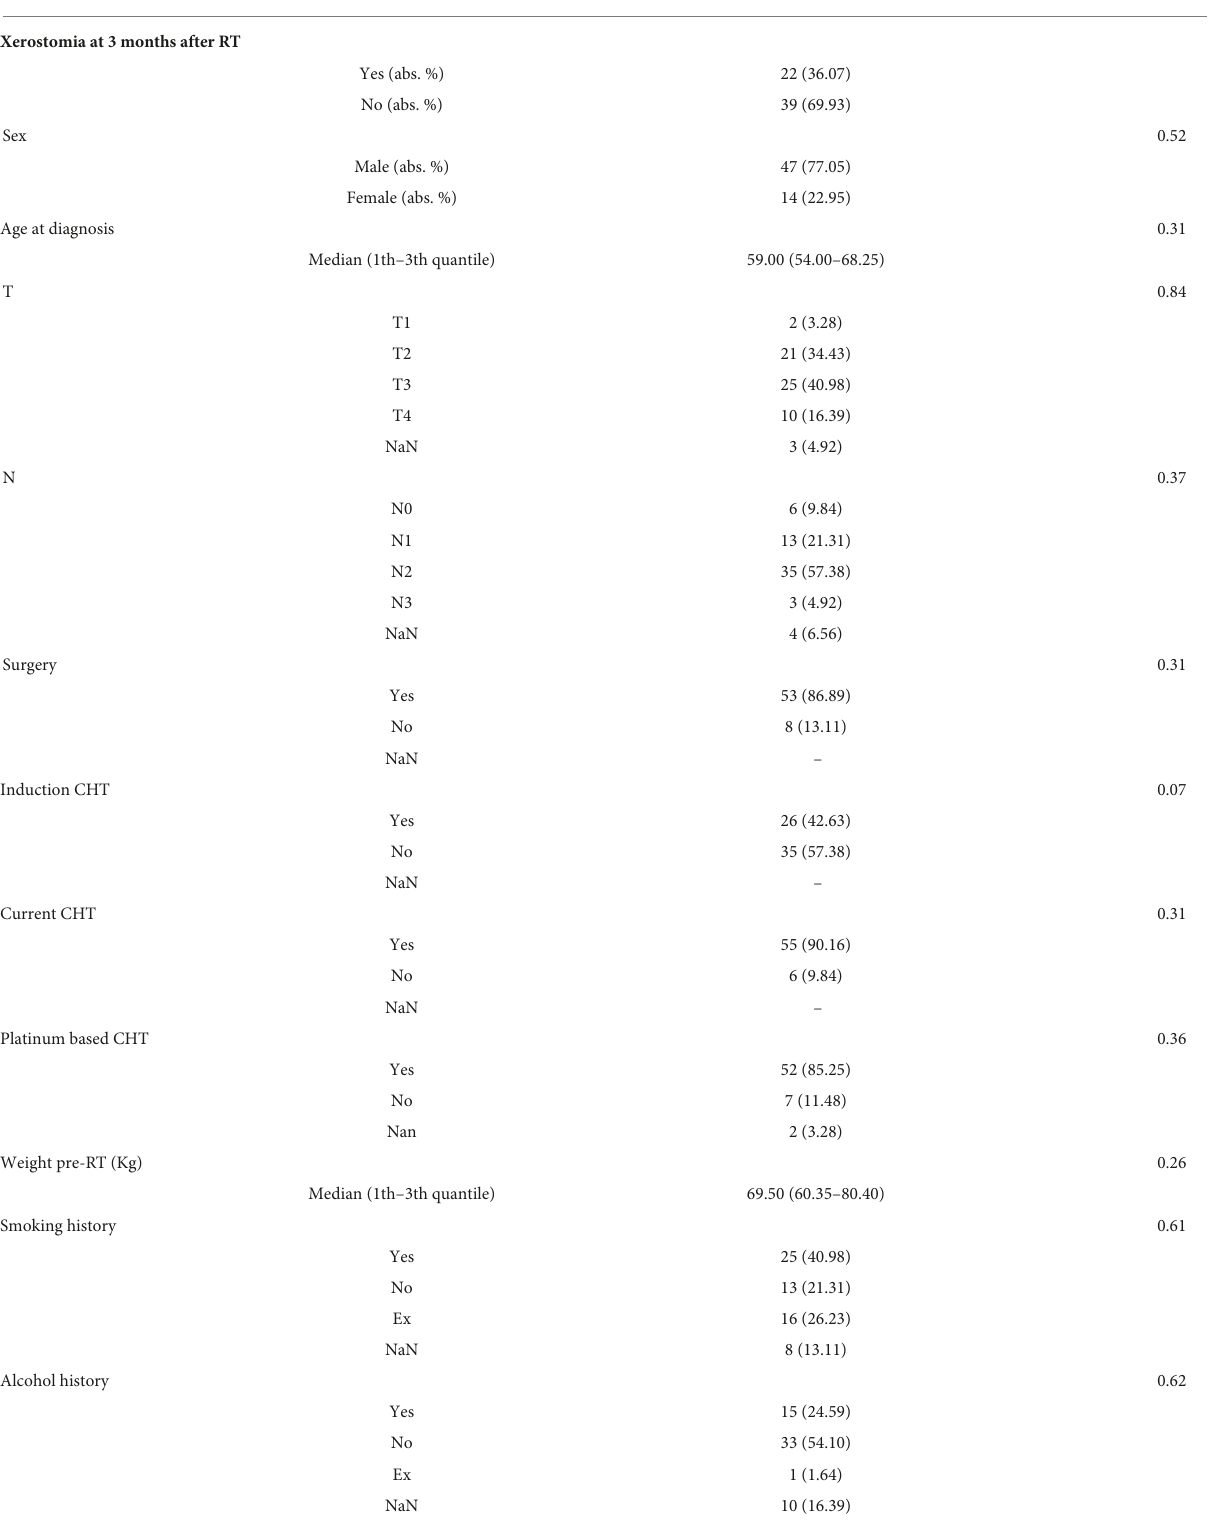
TABLE 1 Sample dataset